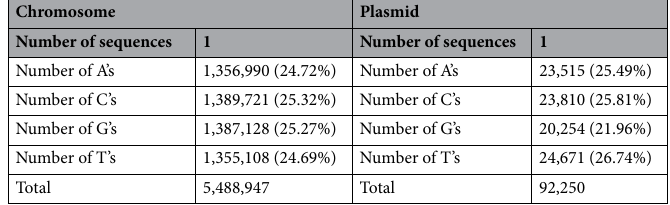
Table 2. Summary statistic of the circularized initial E. coli genome assembly from CANU.